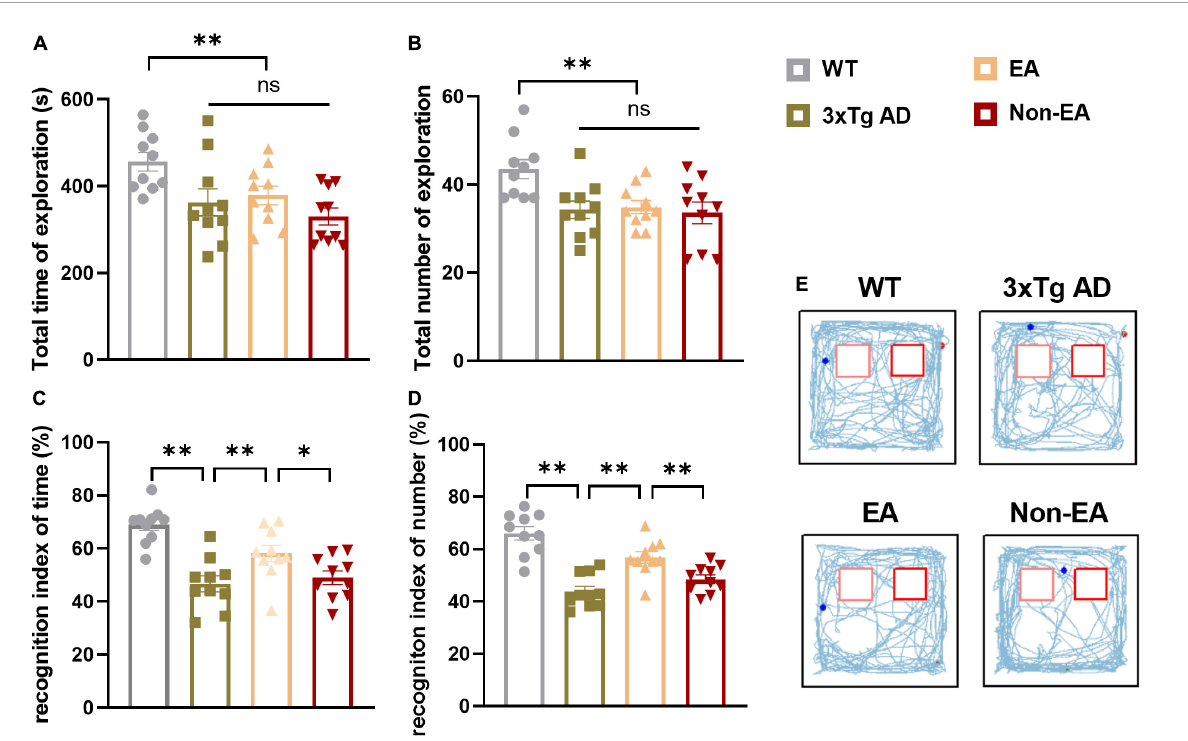
FIGURE2 Effect of EA-treatment on recognition memory in 3 × Tg-AD mice. Quantification of exploratory activity in ORT ( n = 10 in each group), involving (A) the total time spent exploring, and (B) the total number of visits to both objects. Quantification of recognition memory, involving (C) the recognition index of time, (D) and the recognition index of number during probe test. (E) The trajectories of mice during probe test in the ORT. All data represent the mean ± SEM. * P < 0.05; ** P < 0.01; ns, there was no significant